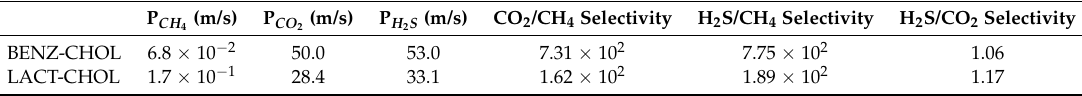
Table 2. Permeability coefficients and selectivities obtained by integrating Equation (1) from | z | = 1.5 nm to | z | = 3 nm (see Figure